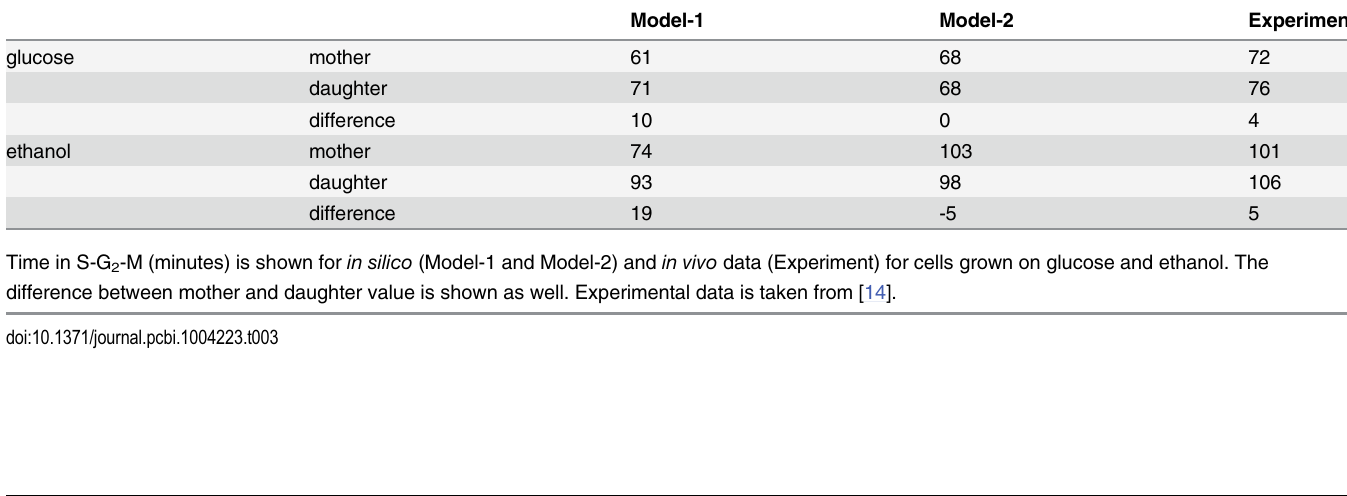
Table 3. Duration of budded